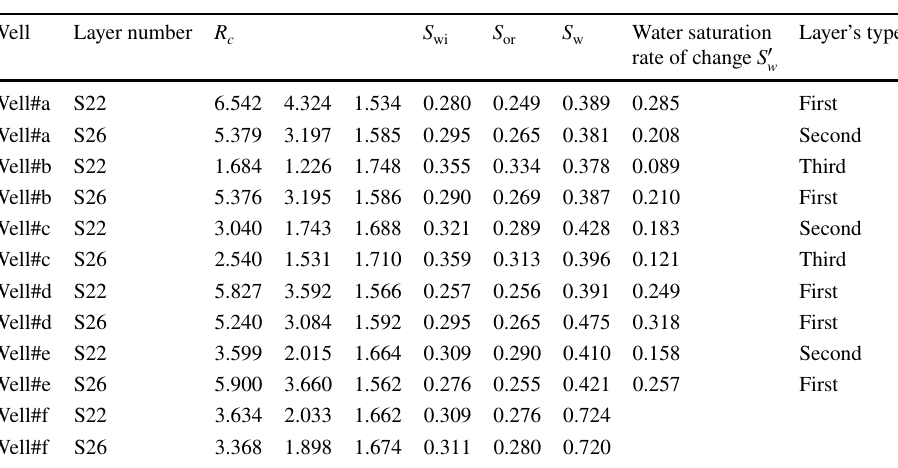
Table 4 gives the current water cutting rate of each layer. And the water cutting rate of the water injection well#f was taken as 1.0. The coefficients c and n , bound water saturation S S wi , and residual oil saturation or were calculated by using formulas (11–14), respectively. The water cutting rates of the S22 and S26 layers of each well were, respectively, brought into formula (5) and formula (15) to calculate the water satu- ration S w and the change rate of water saturation S ′ w . The calculation results are shown in Table 5. The remaining oil saturation of each layer was calculated by formula (6), and the contour map of the remaining oil saturation distribution of the inject-product unit was drawn in the way of interpola- tion, as shown in Fig. 7a, b. Table 5 shows that the remaining oil saturation S o of the S22 and S26 layers is about 60%. In Table 5, the type of each rock layer was determined by its R V S ′ c and sh values. According to the analysis of w above, the